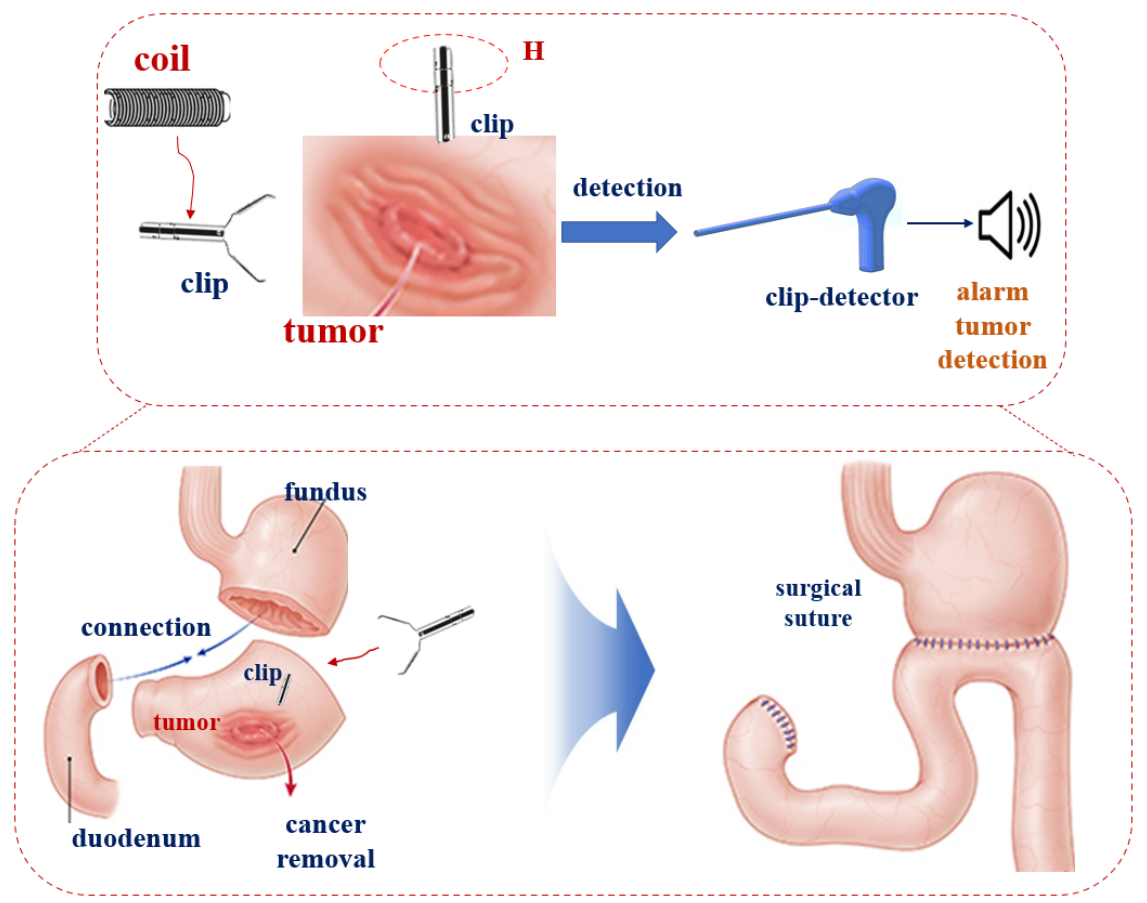
Figure 16. Method of removal and suturing after attaching the clip to the lesion